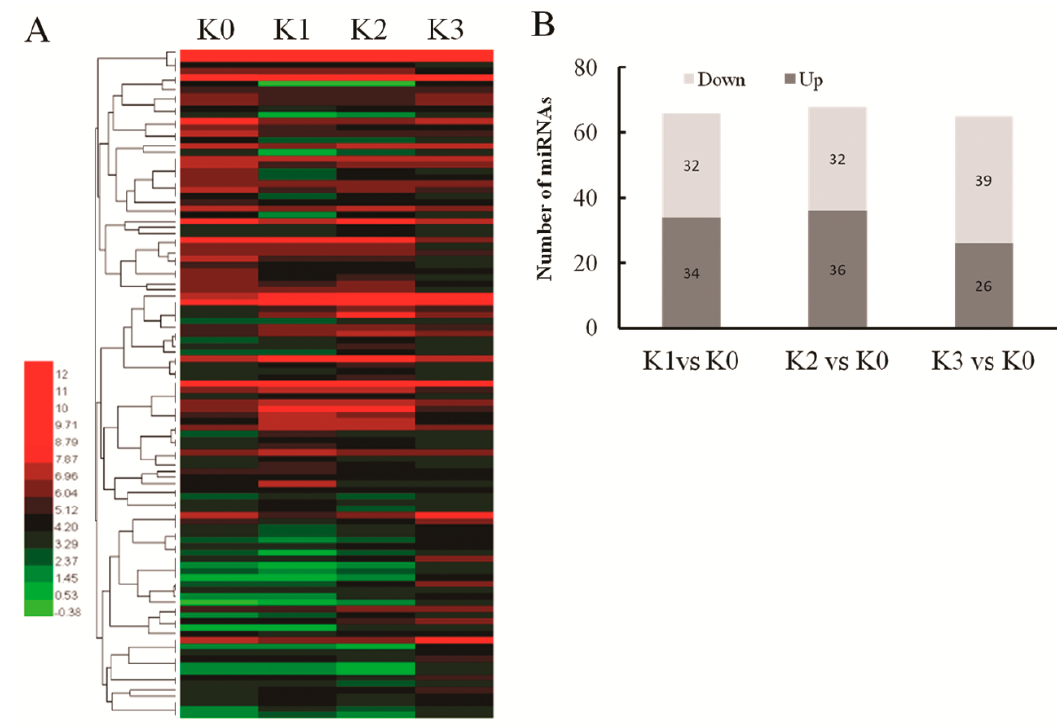
Figure 3. D. zeae -responsive miRNAs in resistant rice. ( A ) Heat plot showing D. zeae -responsive miRNAs identified in an incompatible interaction. ( B ) The number of differentially expressed miRNAs in four